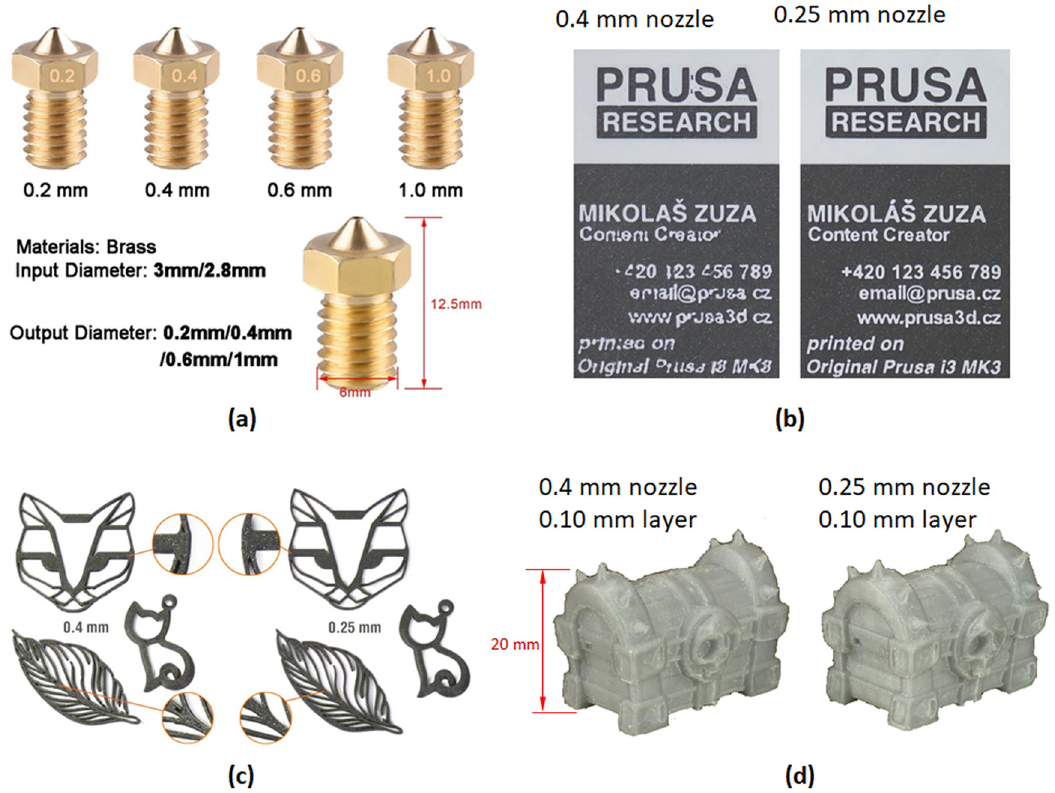
Figure 6: ( a ) Typical commercial FDM nozzle with di ff erent sizes; ( b ) FDM printed texts with di ff erent nozzle sizes; ( c ) FDM printed jewelry with di ff erent nozzle sizes; ( d ) FDM printed miniatures with di ff erent nozzle sizes. Adopted from ref. [ 83 ] with modi fi